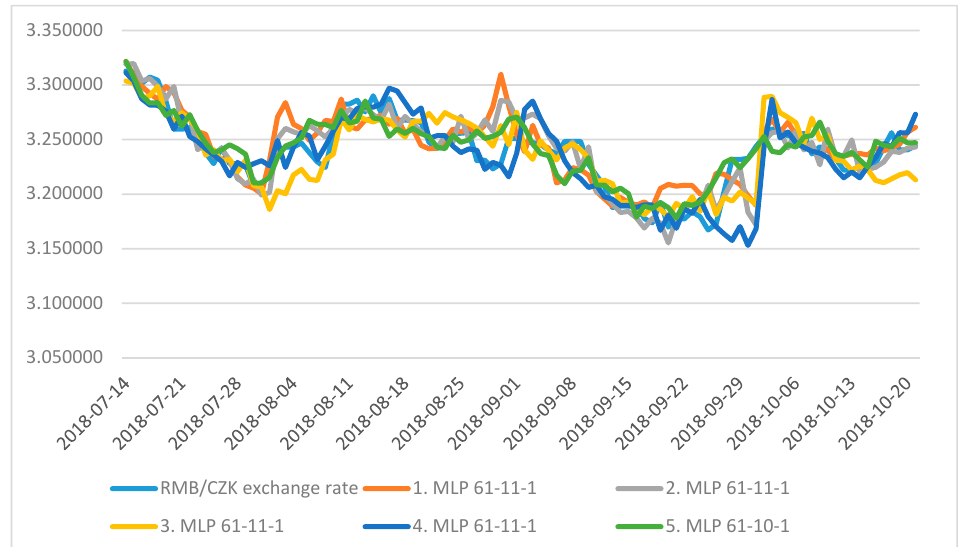
Figure 7. Actual and predicted (according to retained neural networks) development of the CZK/RMB exchange rate for the period from 14 July to 21 October 2018 (Source: Own research).